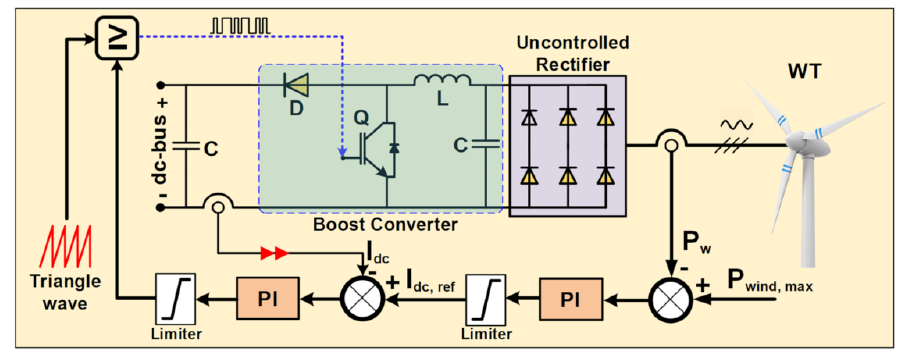
Figure 4. MPPT of the wind